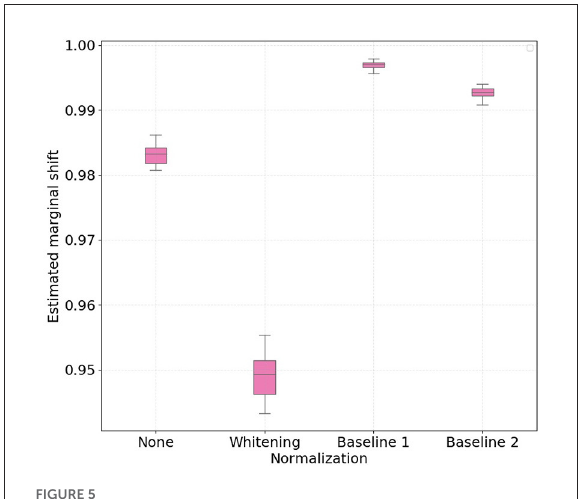
FIGURE5 Boxplots with 30 independent estimates of the aggregate cross-subject marginal shift across different normalization strategies for participants which performed physical activity using a treadmill . Lower values represent smaller estimated marginal shifts.